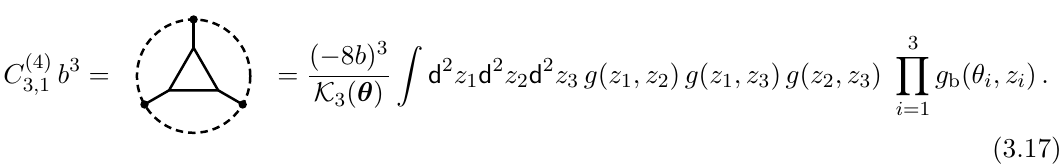
, (cid:18) 2 = (cid:0) 2 (cid:25) 3 3 27